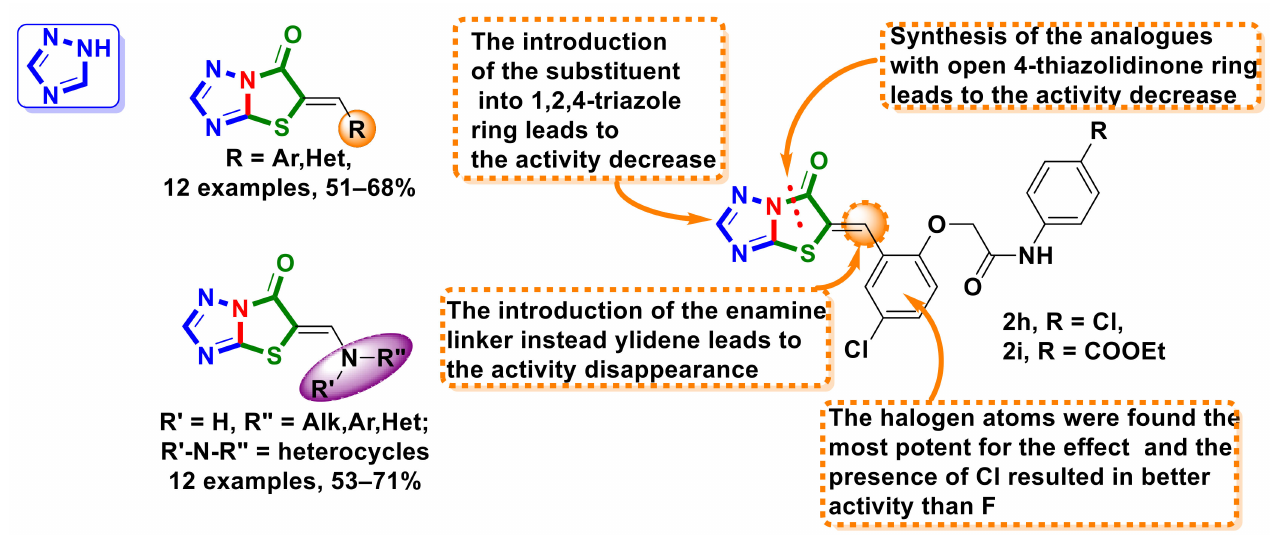
Figure 19. Structures of merged 1,2,4-triazole–4-thiazolidinone hybrids with antimitotic activity.